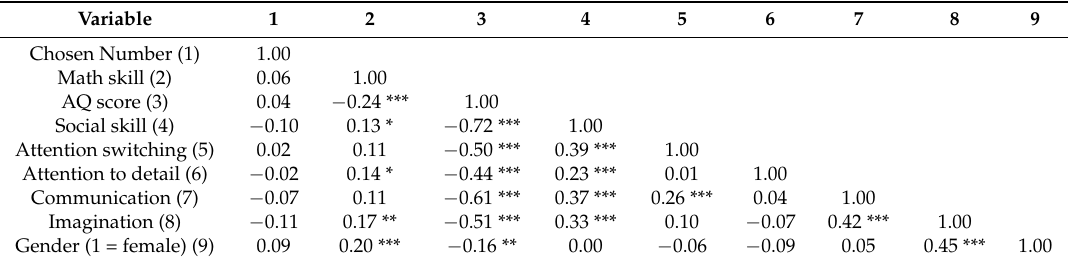
Table 1. Correlations of dependent variables.